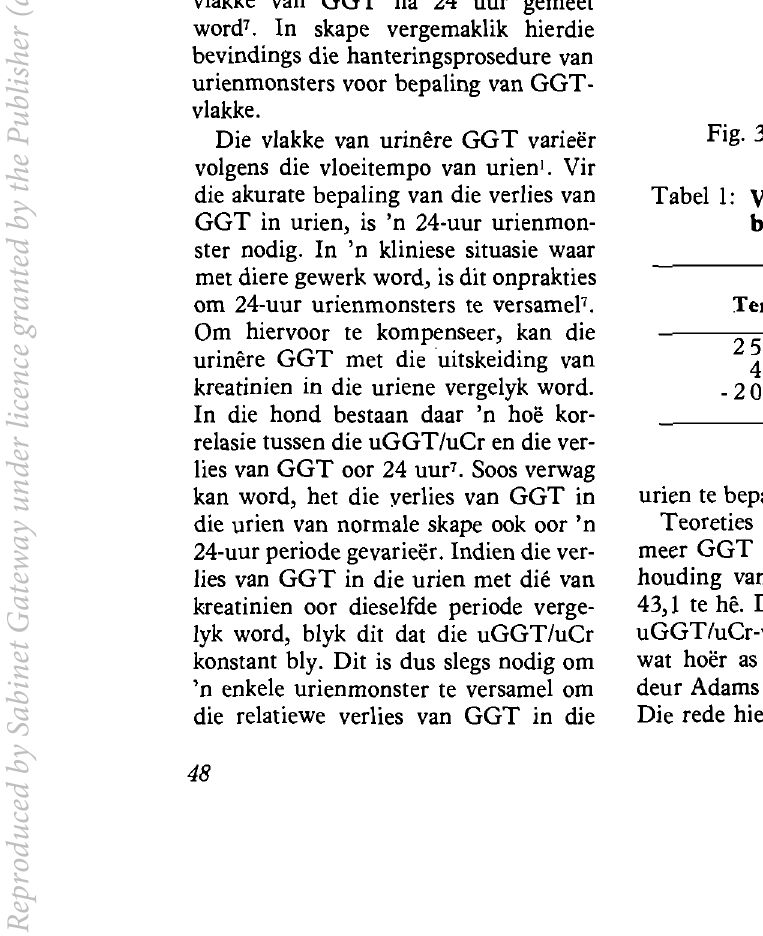
Die rede hiervoor Ie waarskynlik in die